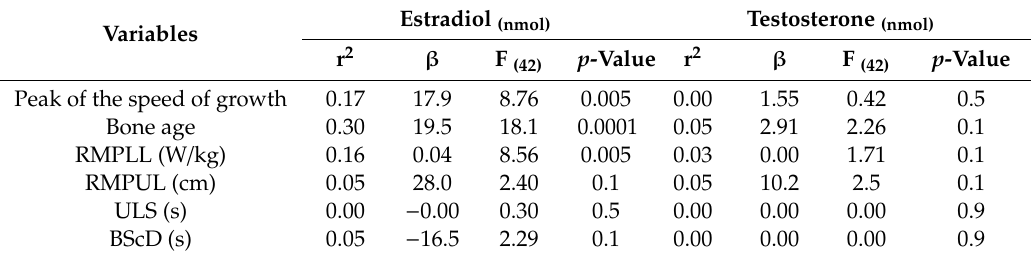
Table 4. Linear regression of the study variables with hormonal markers.